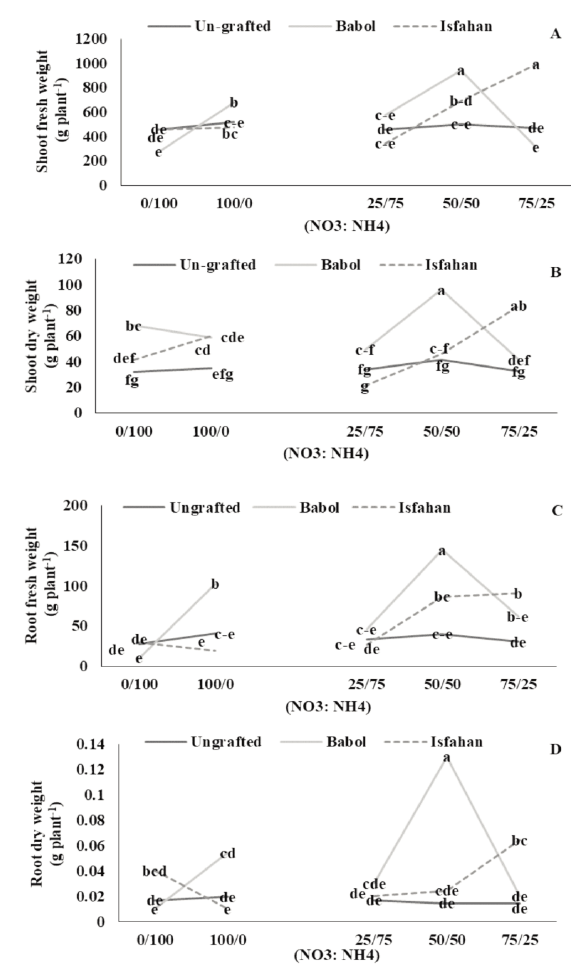
Fig. 2 ­ The interaction effect of different rootstocks and NO :NH ratio on A) shoot fresh weight, B) shoot dry wei­ 3 4 ght, C) root fresh weight and D) root dry weight.